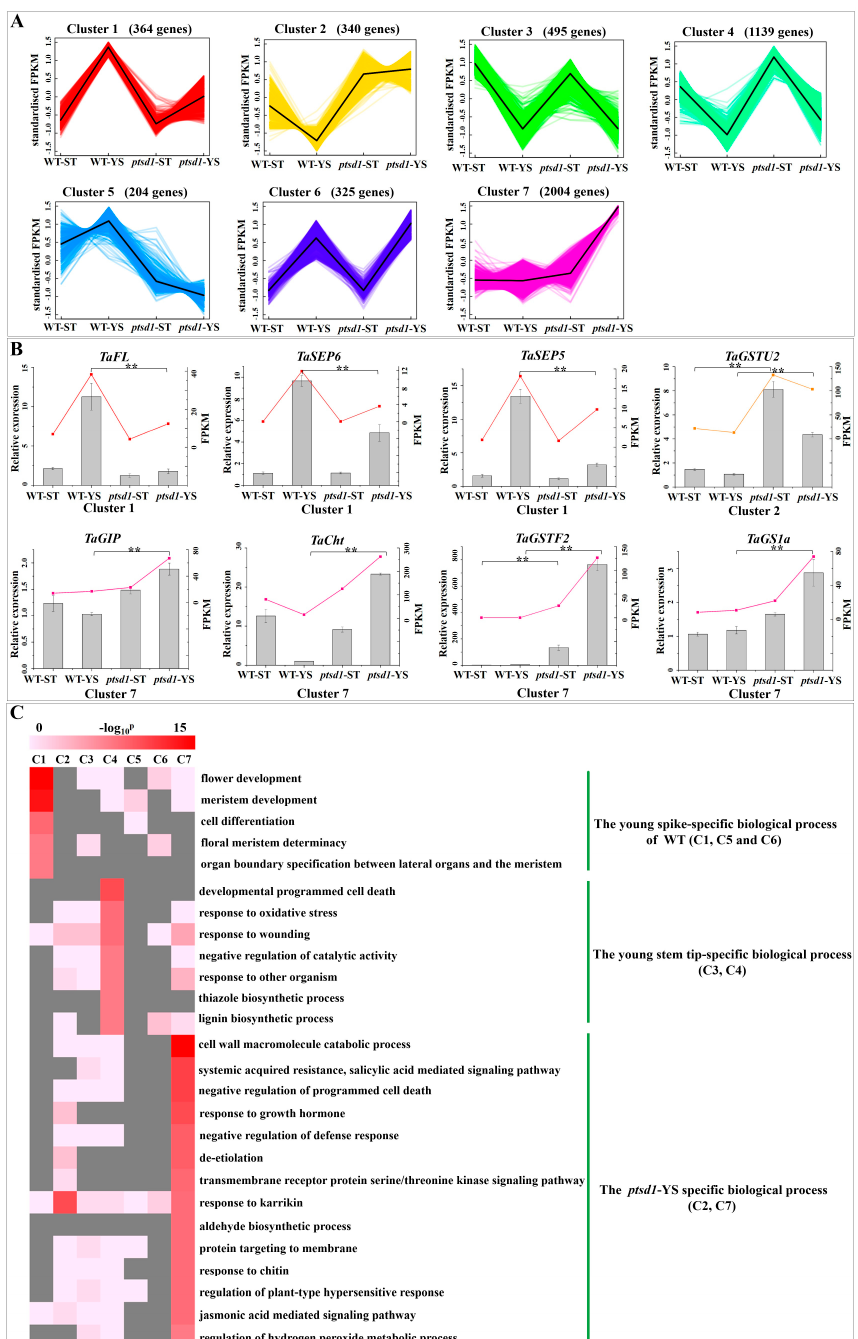
Figure 2. The expression profiles and functional enrichment of the differentially expressed genes (DEGs). ( A ) K -means clusters of the DEGs. The X-axis indicates the samples, Y-axis indicates the normalized fold-changes of the gene expression levels. ( B ) The expression patterns of some key genes verified by real-time qRT-PCR. The X-axis indicates samples. The left Y-axis indicates relative gene expression levels determined by qRT-PCR and the expression values were adjusted by setting the minimum expression as 1 for each gene. The right Y-axis indicates the fragments per kilobase of transcript per million fragments mapped (FPKM). The asterisk indicates the significant difference between different samples (**: p ≤ 0.01). ( C ) GO-term function enrichment of different clusters. The significances of the most represented GO-slims in each main cluster are indicated using log-transformed p -value (red). The dark grey areas represent the missing values. C1–C7: